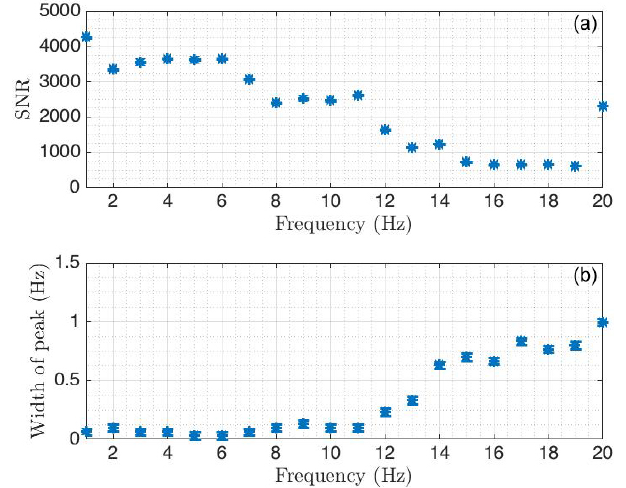
Figure 11. Signal-to-noise ratio (top panel) and width of the peak (bottom panel) detected by the RM3100 as a function of the input signal